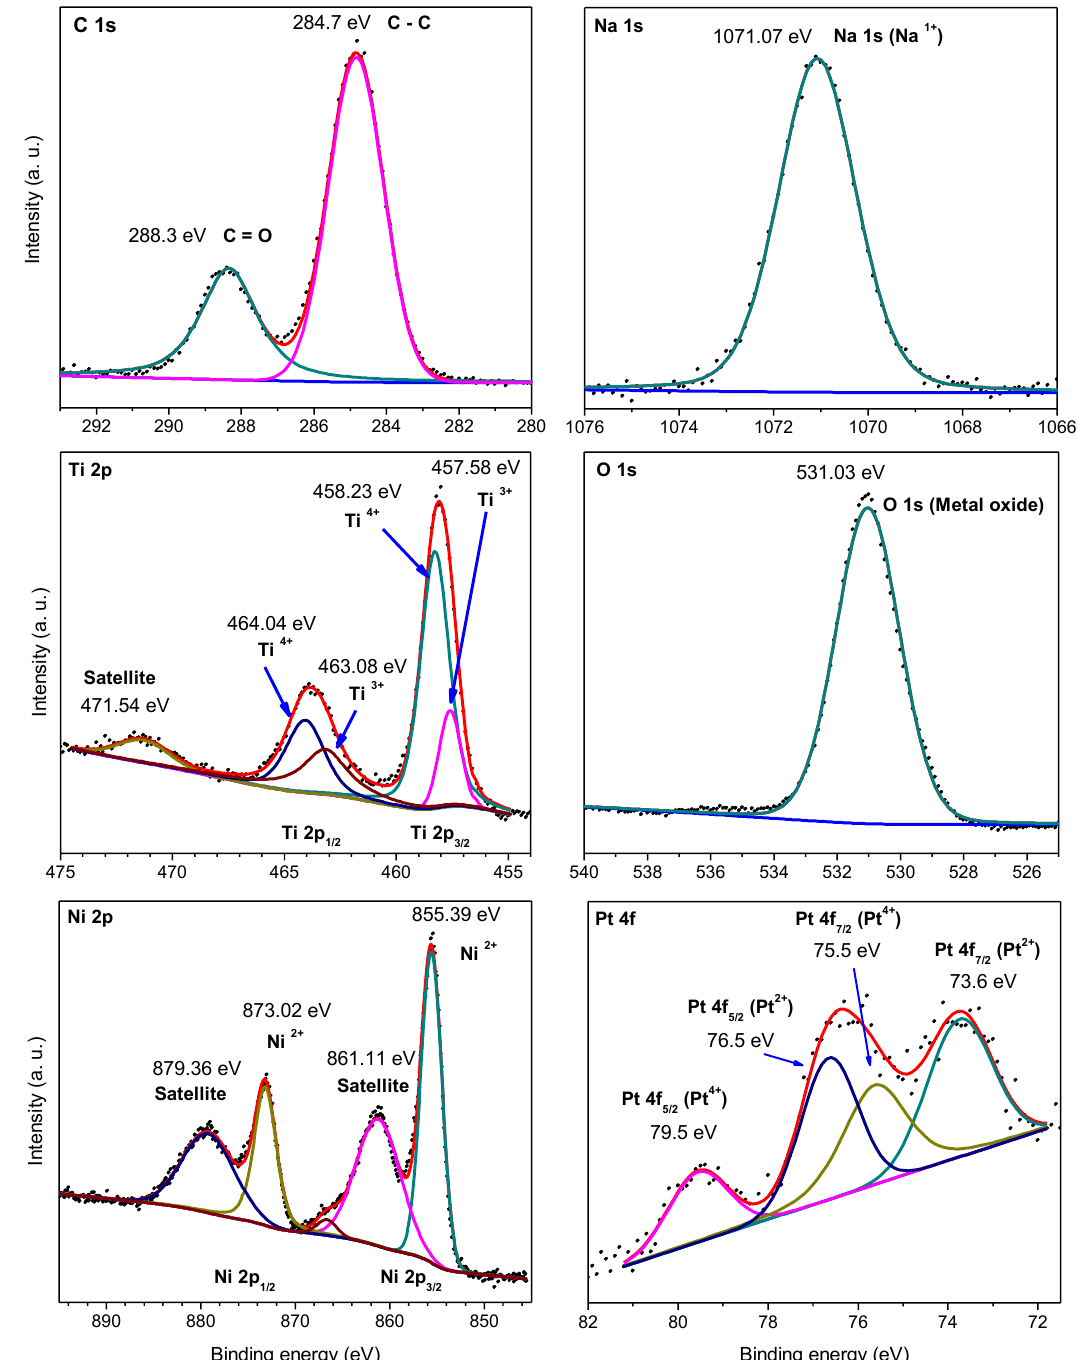
Figure 4. XPS spectra in C 1s, Ti 2p, Na 1s, O 1s, Ni 2p, and Pt 4f zones of the NTO/Pt/Ni sample.